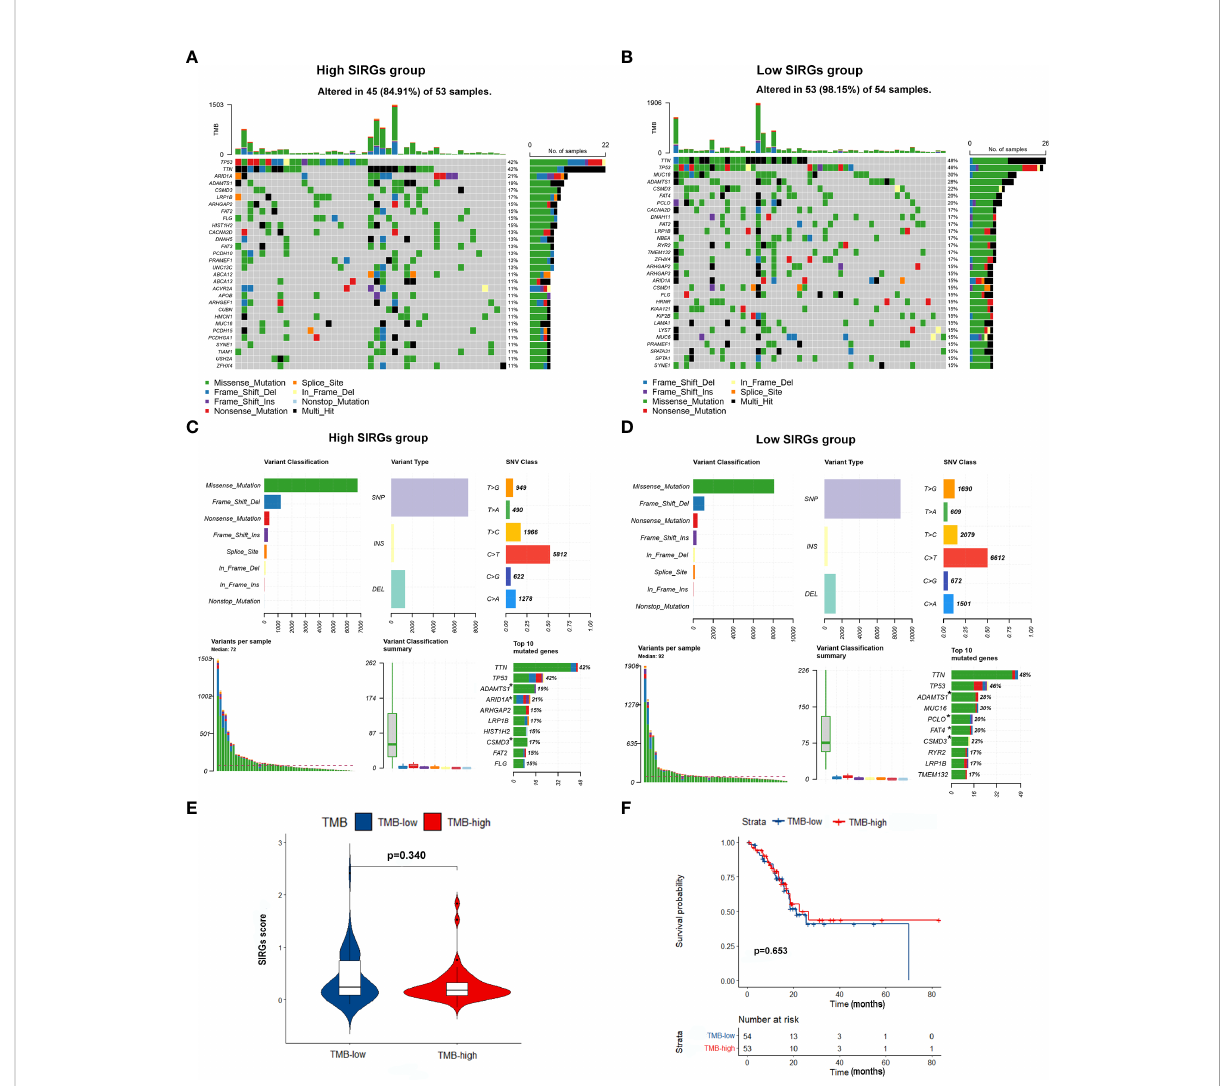
FIGURE 6 The mutation pro fi le and TMB in low- and high-SIRGs score group. (A) Mutation pro fi le of EGJA patients in high SIRGs score groups; (B) Mutation pro fi le of EGJA patients in low SIRGs score groups; (C) The summary of mutation in high SIRGs score groups; (D) The summary of mutation in low SIRGs score groups; (E) The distribution of TMB in low- and high-SIRGs score group; (F) The association of TMB and